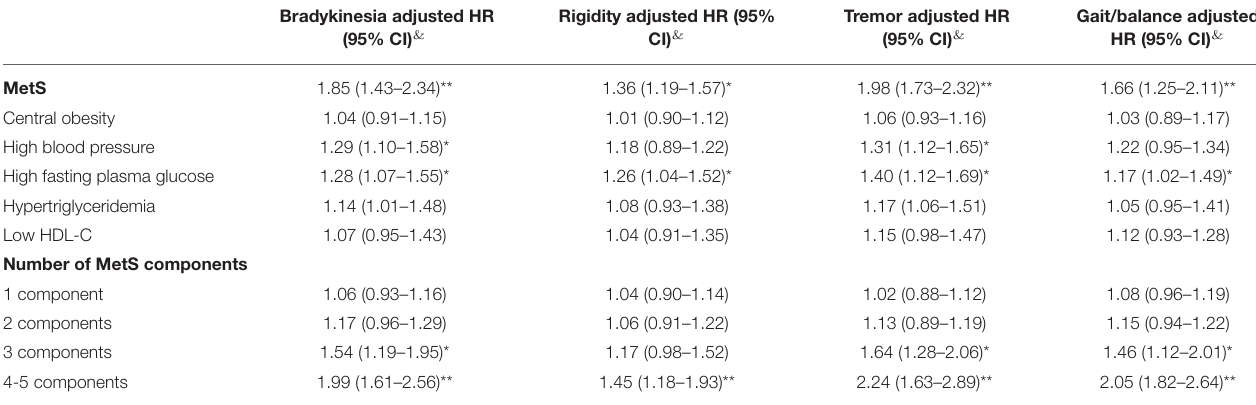
TABLE 3 | MetS with symptom progression of MPS.